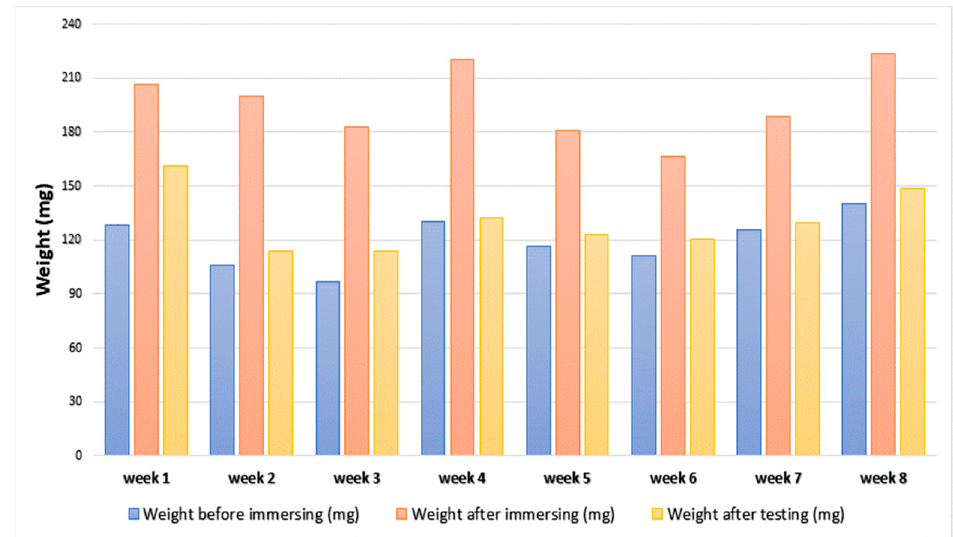
Figure 7. Change of the samples’ weight over the testing period. Table 5. Change of the charge storage capacity in the long-term PANI-based samples.